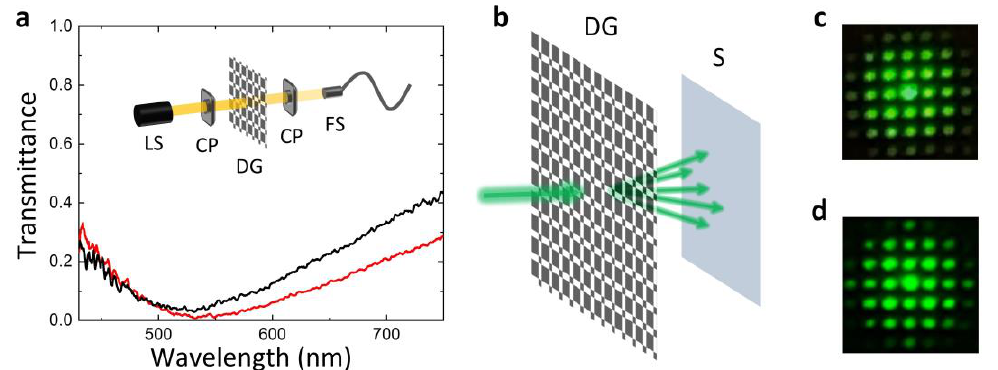
Figure 5. ( a ) Measured (normalized) transmission spectra of the fabricated reference (black line) and customized (red line) Dammann gratings between two parallel circular polarizers. ( b ) Schematic of diffraction pattern characterization of the fabricated LC Dammann gratings. ( c ) Recorded diffraction pattern for the reference grating. ( d ) Recorded diffraction pattern for the customized grating where the phase profile has been optimized. LS: light source; CP: circular polarizer; DG: Dammann grating; FS: fiber spectrometer; S: screen.